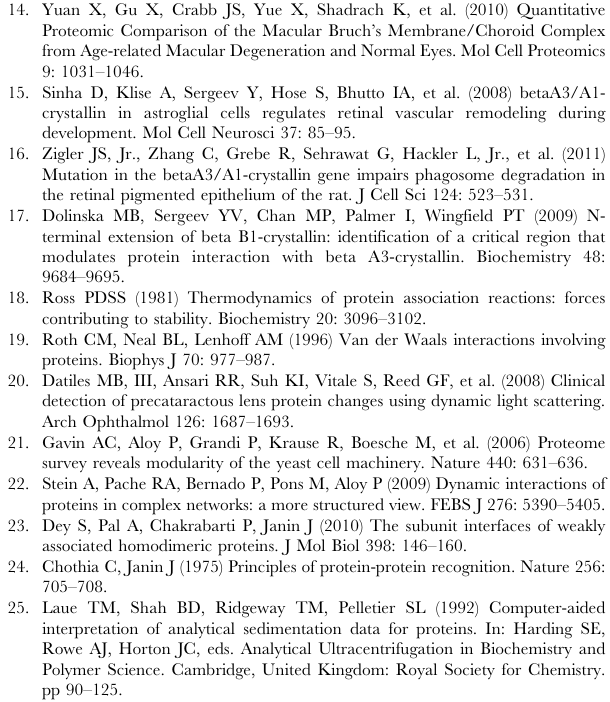
figure. Figure S2 Sedimentation equilibrium profiles of b B1 and b B1/ b A3 complex at various temperatures. In the main panels, open circles show the protein concentration profile represented by the UV absorbance gradients in the centrifuge cell at 280 nm. The solid lines indicate the calculated fits for the b B1monomer-dimer (Panel A) or heterodimer – heterotetramer b B1/ b A3 complex (Panel B) associations. Residuals in the smaller upper panels show the difference in the fitted and experimental values as a function of radial position. In many of the profiles, the residuals at the bottoms of the cells reveal systematic patterns indicative of aggregating protein; this data was not included in the analyses.